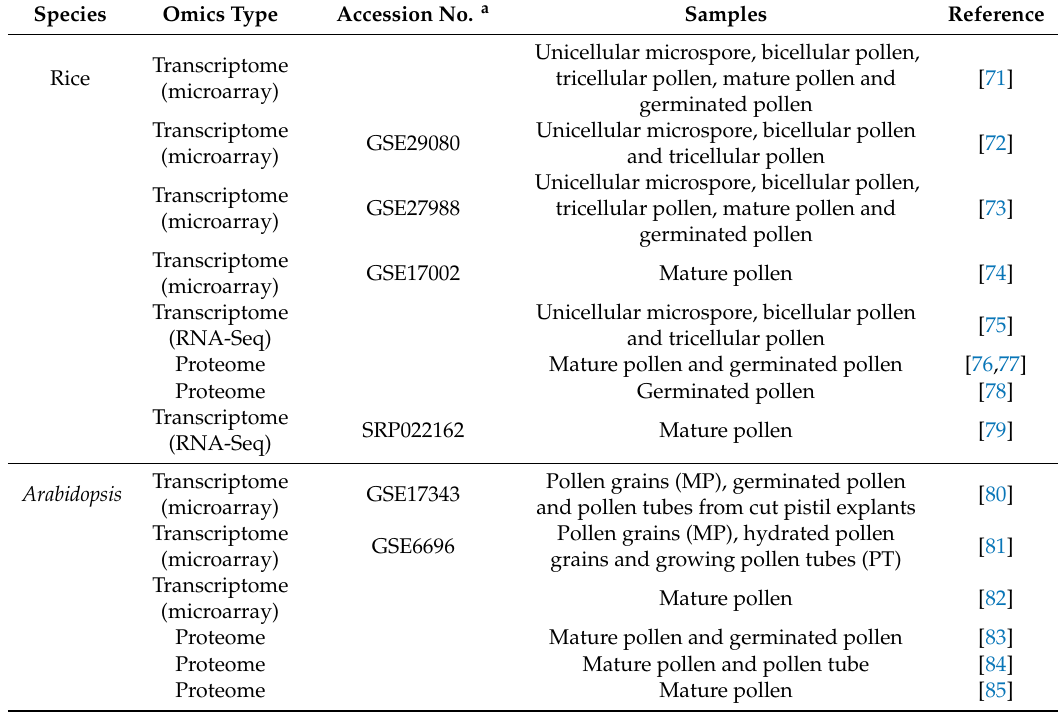
Table 2. Summary of the omics data, including potential candidate genes for pollen hydration and germination in rice and Arabidopsis